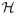
Locus of the trendline parameters (a, b) in the hyperbolic plane H for the Canberra distance dijC and the 11 countries analyzed, t ∈ [1960, 2015] and equal weights.The diameter and color of the circles are proportional to the value of R2. The dashed line delimits the clusters C1 and C2.